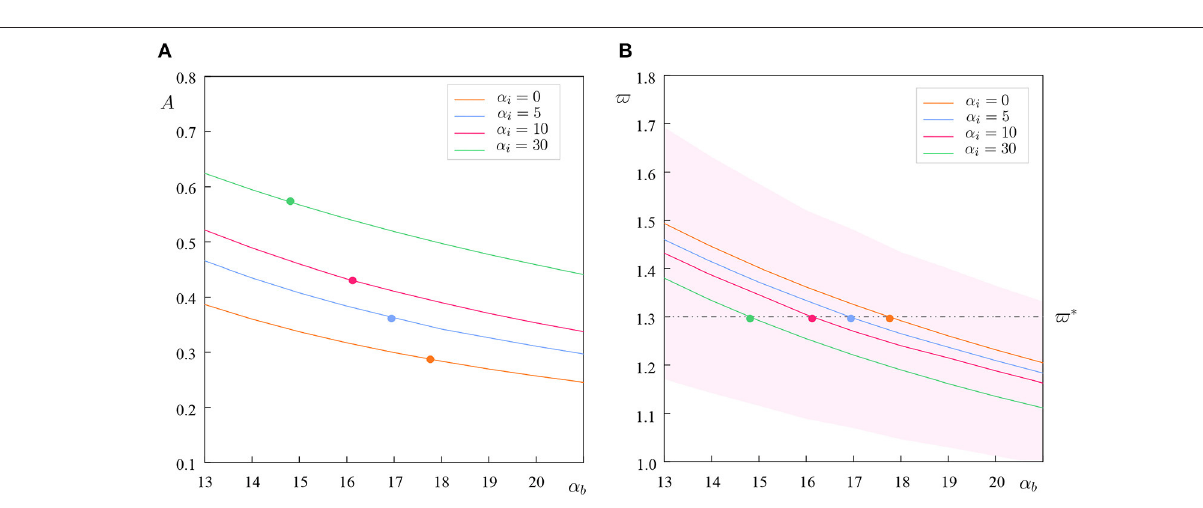
asymptotically approximate the inverse problem